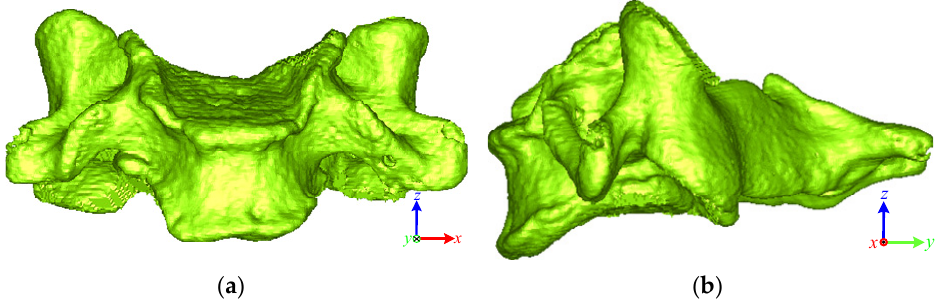
Figure 2. Local coordinate of the vertebra: ( a ) anterior view; ( b ) lateral view. The three points P 1 , P 2 , and P 3 were defined on the OSP of the vertebrae for initial superposition, as shown in Figure 3. Assume that L y is the length in the y -direction of the bounding box of the vertebral contour on the OSP. Based on the bending value method [27], a normalized bending value method was proposed for 3D application to obtain mul- tiple turning points (blue dots in Figure 3) within the γ *L y region from the y min end: